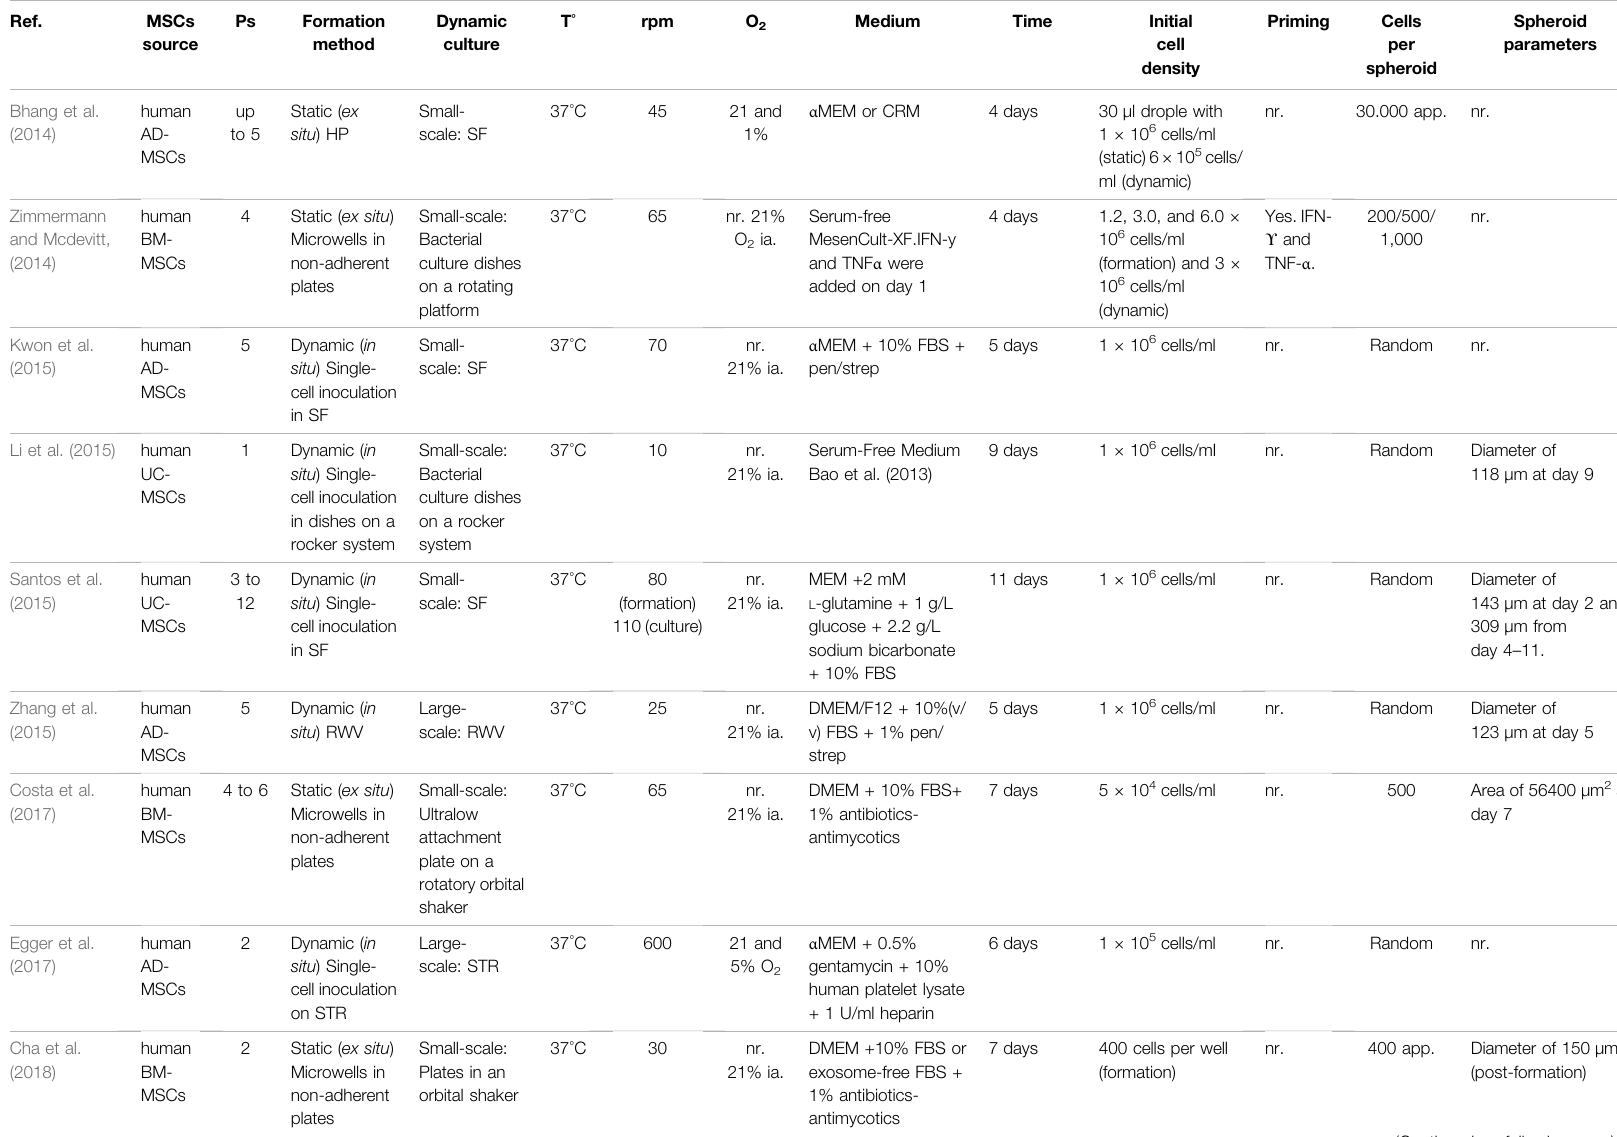
TABLE 1 | ( Continued ) Comparison of different studies reporting static and dynamic methods of spheroid formation and their results for the dynamic cultivation of MSC spheroids.